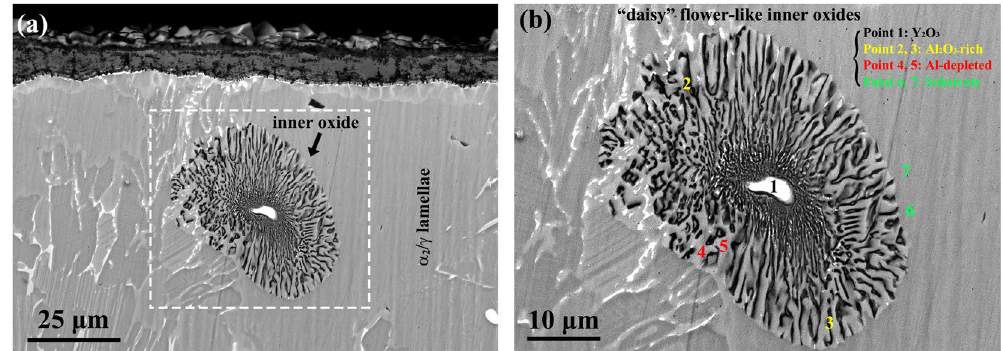
Figure 5. “Daisy” flower-like morphologies of an inner oxide after oxidation at 900 °C for 50 h. ( a ) A low- magnification image showing the location of inner oxide with respect to the scale-substrate interface, and ( b ) a magnified image of Fig. 3(a) showing the oxide details consisting of a core Y 2 O 3 particle surrounded by divergent Al 2 O 3 and oxygen-rich α 2 -Ti 3 Al, where the EPMA microanalysis locations are marked by “1”–“7” with the obtained results summarized in Table